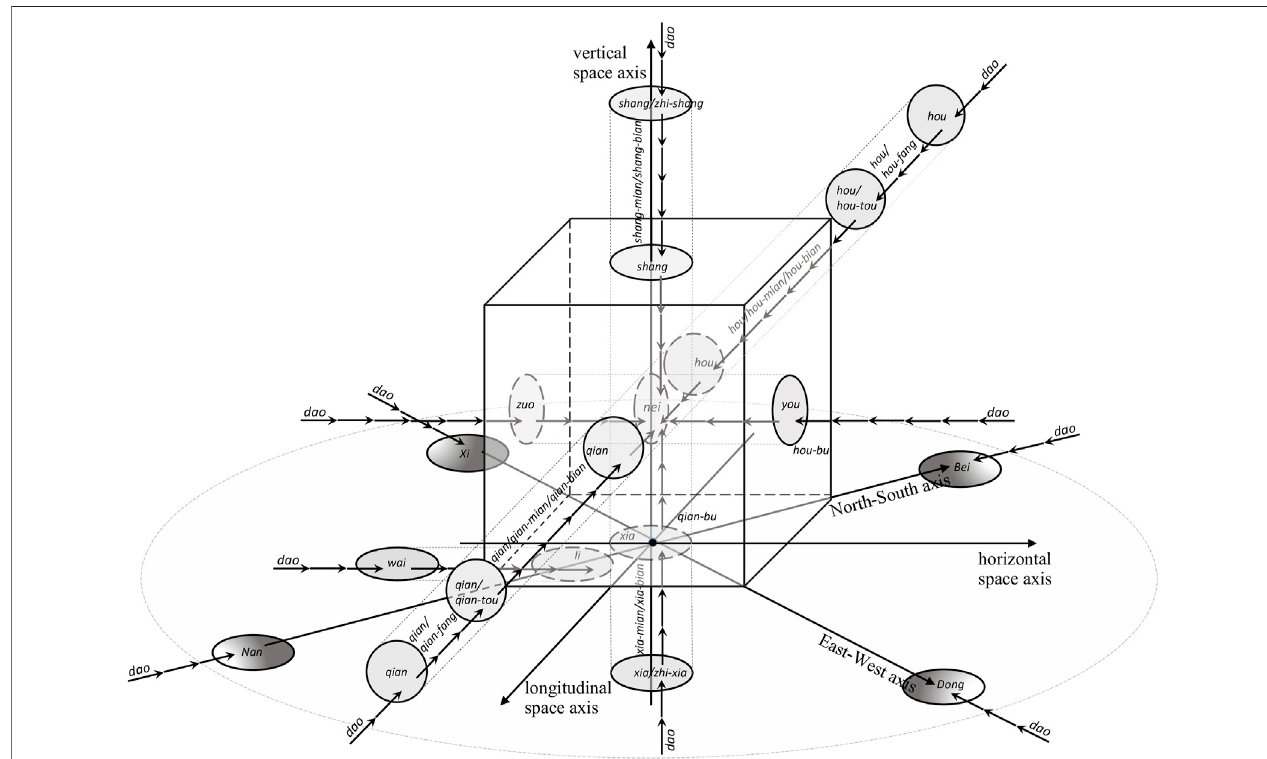
FIGURE3| Thesemanticmapfor dao .Themaprepresents dao ’ shaloindirectly:allthepathsreachingtheground,orlocations/regionsde fi nedwithrespecttothe ground, are part of the region/halo that dao covers. This entails that when sentences describe forms of directed movement, they can lack localisers. This is the case because dao can refer to the location that a fi gure reaches as one of the possible “ goals ” of the fi gure.